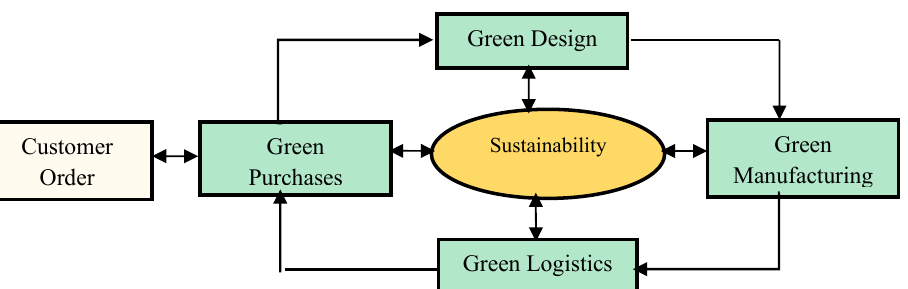
Fig. 2. Pictorial representation of GOM